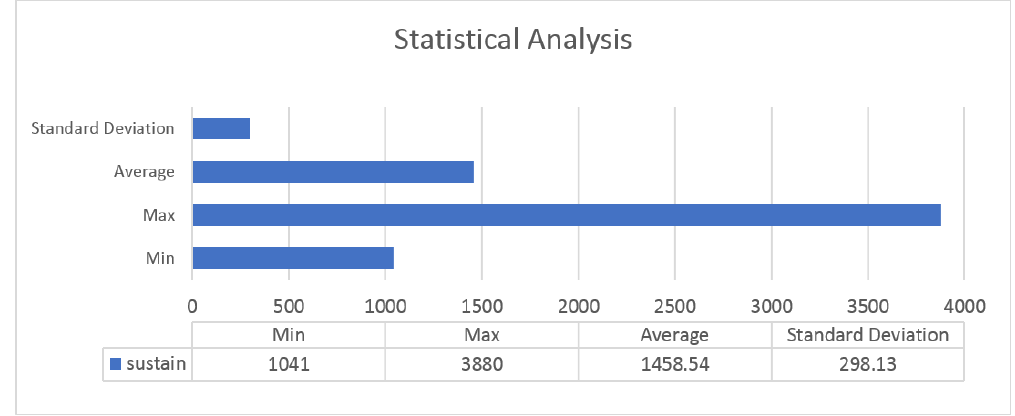
Figure 8. Statistical analysis of 300 acceptances.